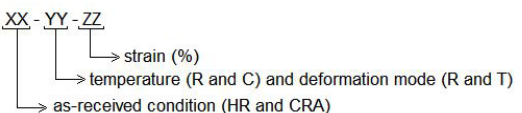
Figure 1. Short nomenclature established for samples in